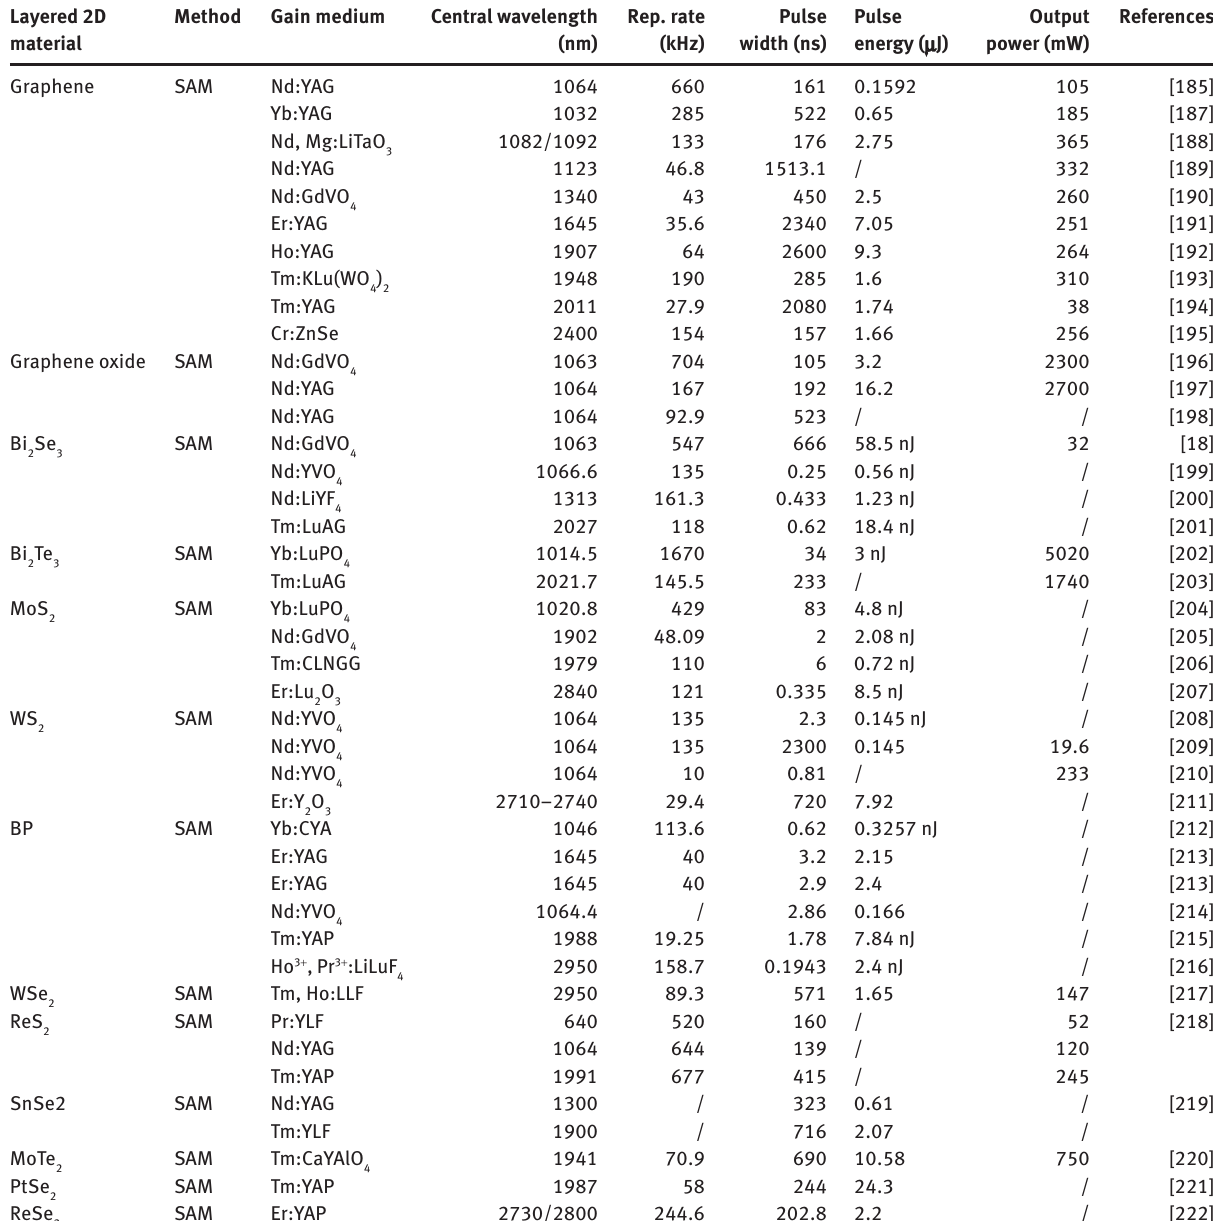
Table 3: Summary of Q-switched solid-state lasers based on layered 2D materials. Layered 2D material Graphene